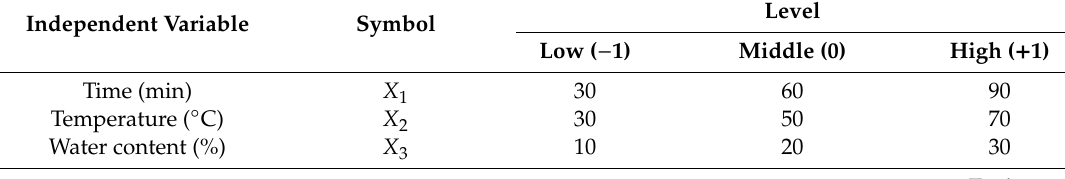
Table 2. Coded and actual levels of the independent variable for the Box-Behnken design with experimental hesperidin